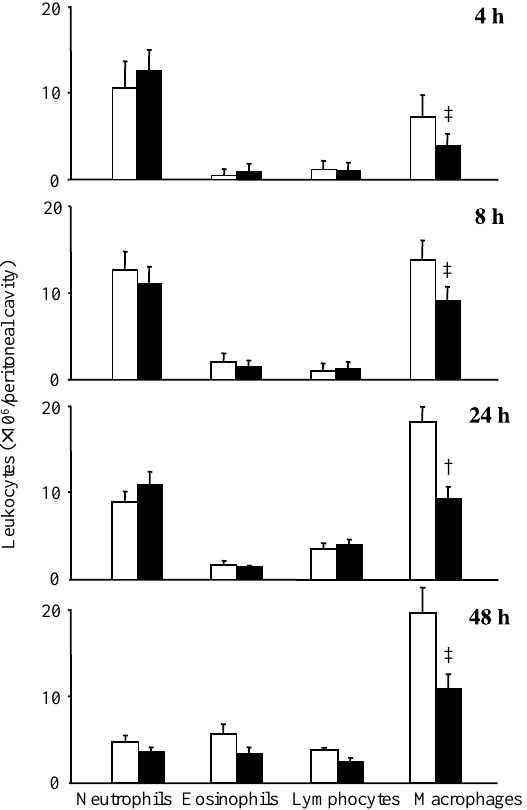
FIG. 2. Effects of neutralization of CCL6 on the leukocyte infiltration induced by thioglycollate. Either 0.5 ml of anti- CCL6 antiserum (closed columns) or control serum (open columns) was intraperitoneally injected 2 h prior to thiogly- collate injection. At indicated intervals after thioglycollate injection, mice were euthanized and the infiltrating leuko- cytes in the peritoneal cavity were harvested (each group, 10 mice). The numbers of neutrophils, eosinophils, lympho- cytes and macrophages were then counted. % p B / 0.05, $ p B / 0.001, when compared with control. Mediators of Inflammation (cid:1) Vol 13 (cid:1)